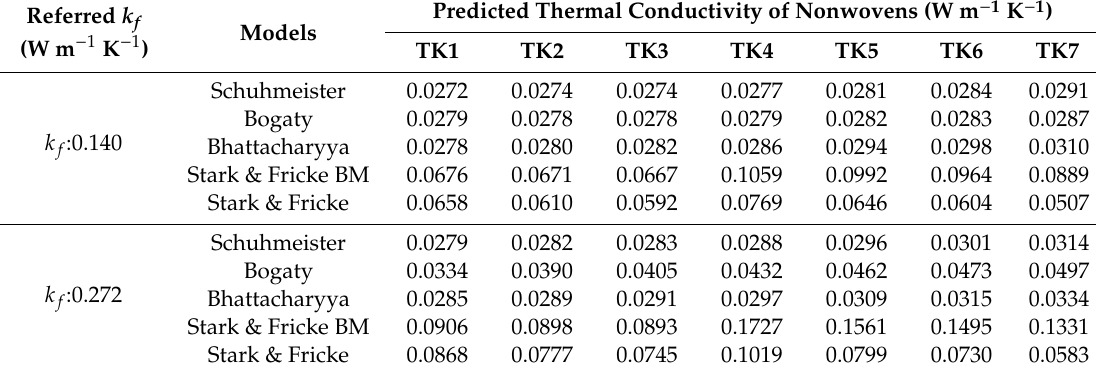
Table 7. Predicted thermal conductivities of nonwoven samples based on di ff erent k f . Referred k